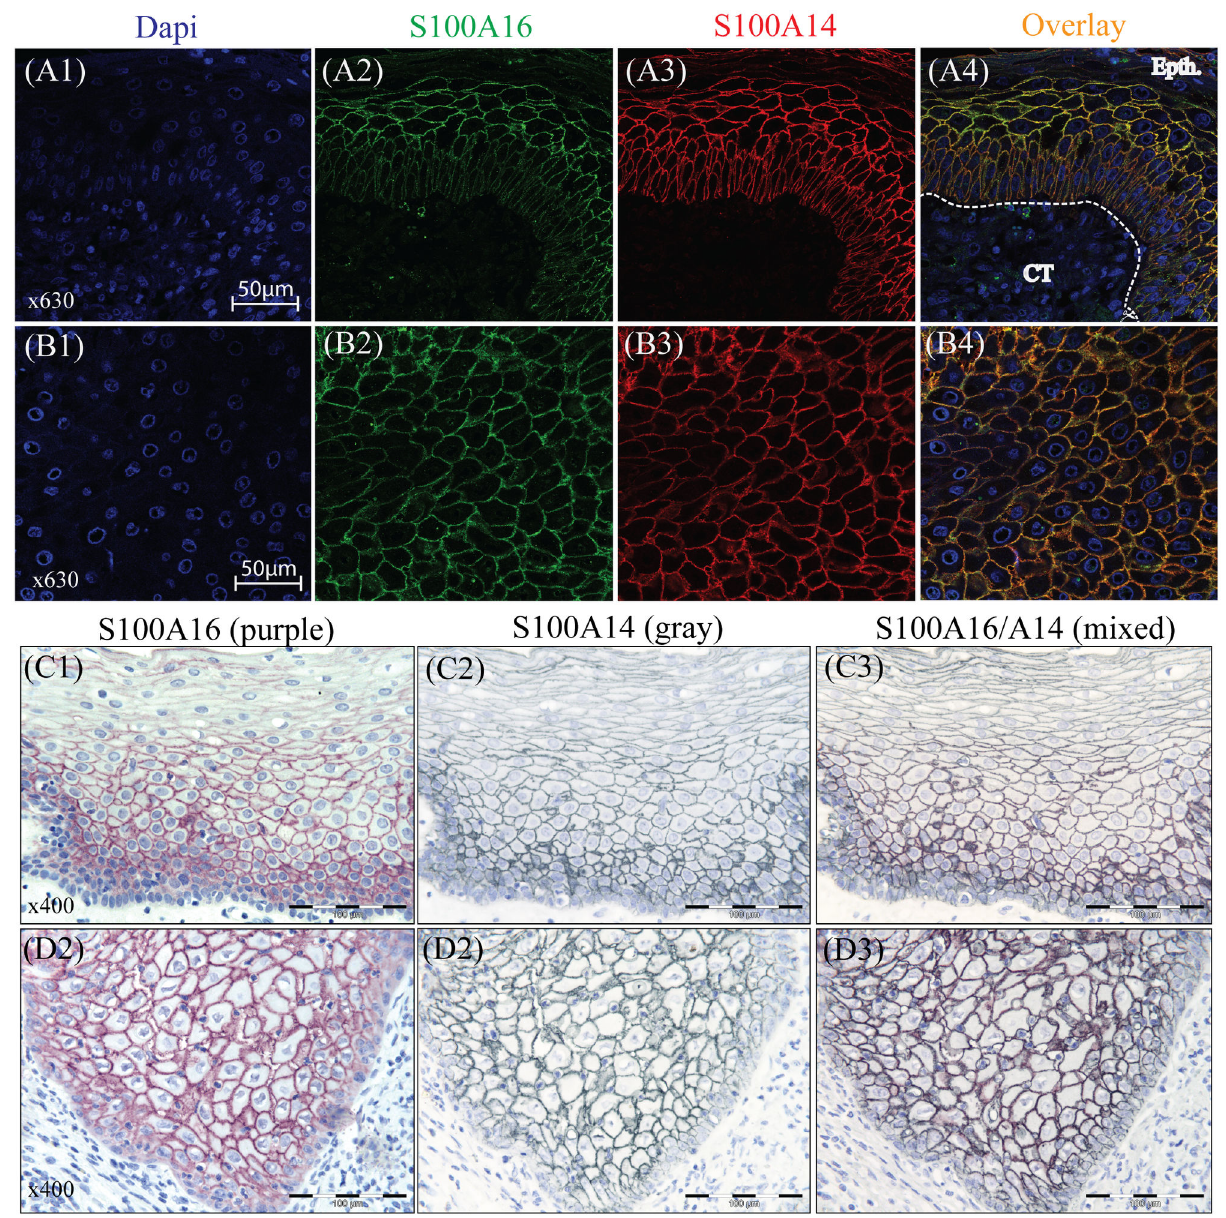
Figure 2. Co-localization of S100A14 and S100A16 in the specimens of OSCC and normal oral mucosa. Cellular localization of S100A14 and S100A16 was examined by performing DIF and IHC in the sections of formalin fixed and paraffin embedded OSCC and normal oral mucosal tissues. Predominantly membranous localization of S100A16 (green), S100A14 (red) and S100A16/A14 (yellow) was visualized in the epithelial cells of normal mucosa (A1-A4) and OSCC (B1-B4) tissues by DIF (Epth, epithelium; CT, connective tissue). Similarly, with single and double IHC on the serial sections, predominantly membranous expression of S100A16 (purple), S100A14 (gray) and S100A16/A14 (mixed color) was detected in the normal mucosa (C1-C3) and in the OSCC (D1-D3). doi: 10.1371/journal.pone.0076058.g002 screen are consistent with previous Y-2H screens for different 24). One of the suggested reasons for S100 isoform dominated S100 proteins. Similar to our findings, interacting partners for interaction in Y-2H could be a function of tightly controlled other S100 proteins from previous Y-2H screens are also intracellular Ca 2+ concentration (200nM) in yeast cell [25] which largely dominated by the S100 protein isoform(s) (reviewed in is far below the calcium K values of many S100 proteins d